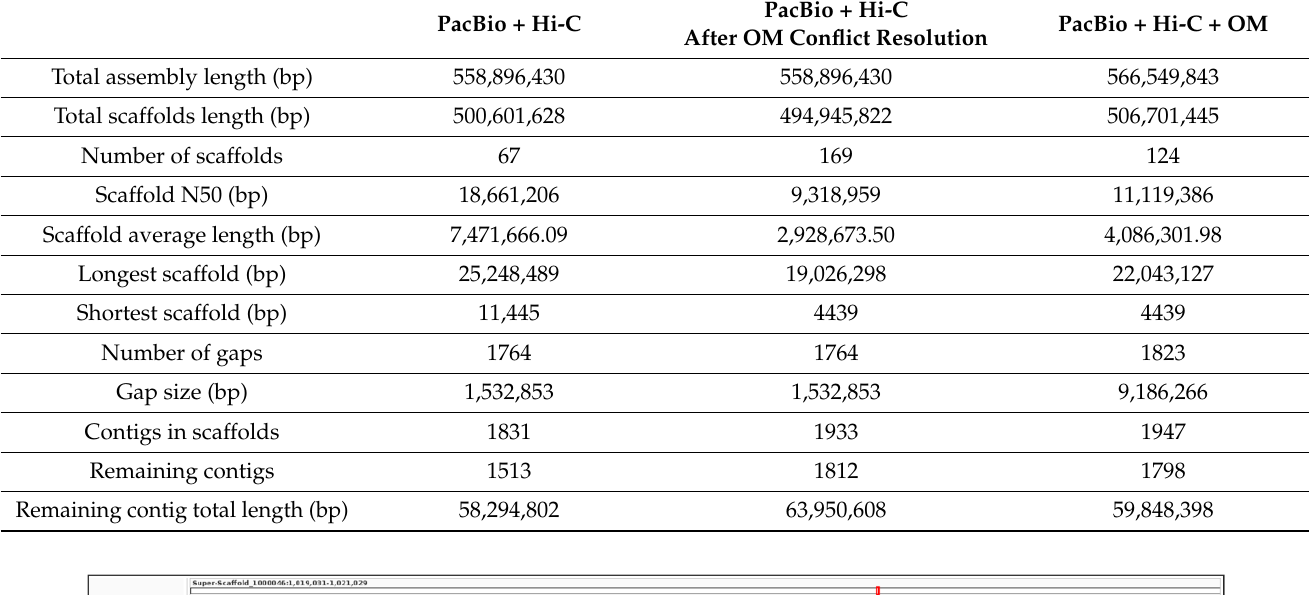
Table 3. Statistical data for the L. albus assembly generated with PacBio data (PacBio assembly [25]), the correction with optical maps (PacBio + Hi-C after OM conflict resolution) and the final hybrid scaffold integrating the PacBio assembly with Hi-C and optical maps scaffolding (PacBio + Hi-C + OM).